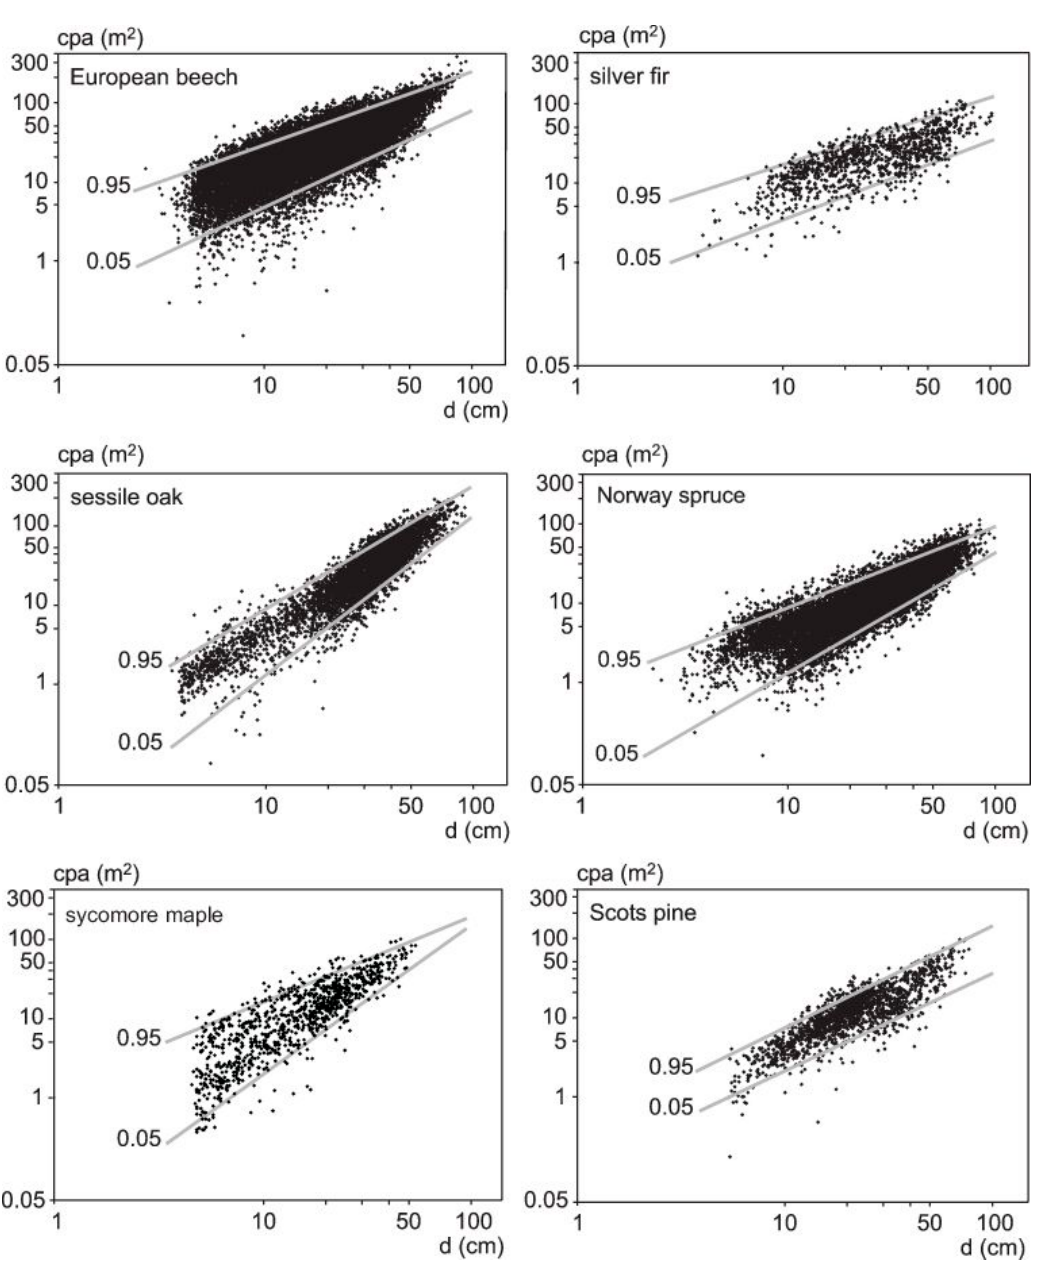
Figure 4. Allometric relationships between stem diameter, d, and crown projection area, cpa, for European beech ( Fagus sylvatica L.) (n = 14,898), silver fir ( Abies alba Mill.) (n = 1079), sessile oak ( Quercus petraea (MATT.) LIEBL.) (n = 4485), Norway spruce ( Picea abies (L.) Karst.) (n = 10,724), sycomore maple ( Acer pseudoplatanus L.) (n = 942), and Scots pine ( Pinus sylvestris L.) (n = 1609) in even-aged and uneven-aged stands. The graph shows the range of crown dimensions measured on long-term experimental plots which cover dense as well as very sparsely spaced stands. The upper and lower lines represent the results of the 95% and 5% quantile-regression ln(cpa) = a + α × ln (d) . The width of the scattering and the distance between the 95% and 5% quantile regression represents the crown plasticity, CPL. For the statistical characteristics of the quantile regressions see Pretzsch (2014) [10].